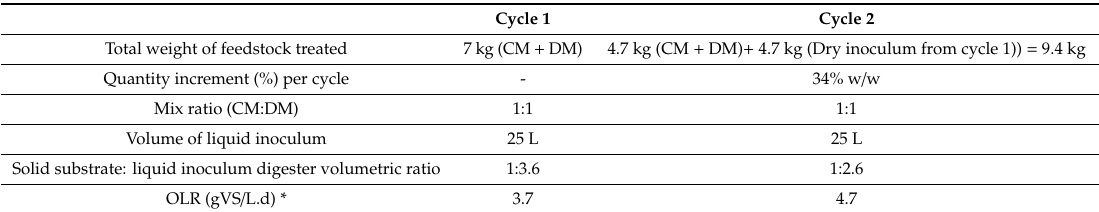
Table 1. Summary of the materials used.